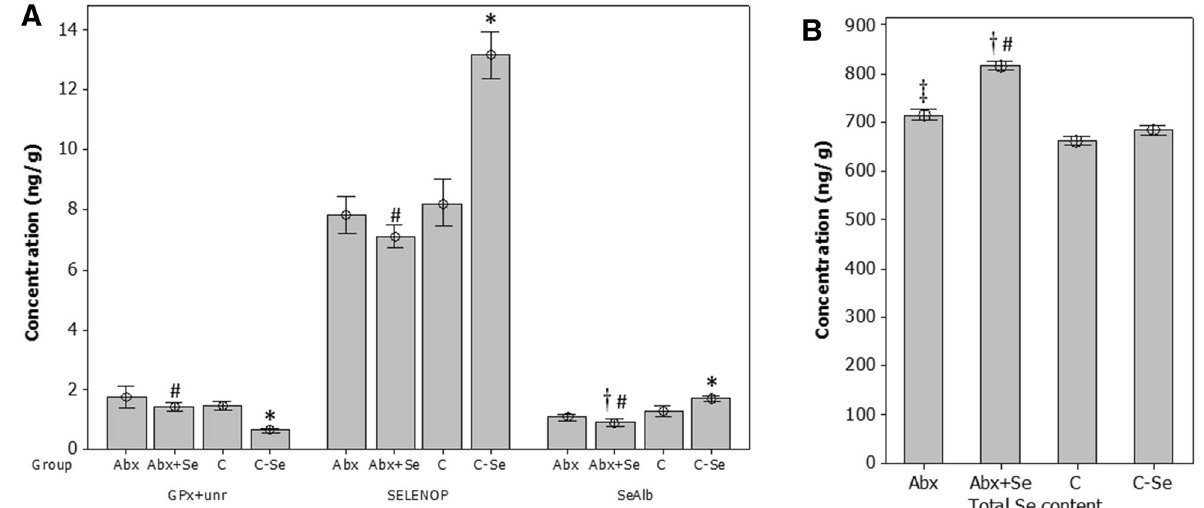
Figure 3. Selenoproteins ( A ) and total Se concentration ( B ) in the mouse testis. Data are expressed as mean ± SD (n = 10). (*) Statistically different in C-Se vs C comparison. (†) Statistically different in Abx + Se vs C comparison. (#) Statistically different in Abx + Se vs C-Se comparison. (‡) Statistically different in Abx + Se vs Abx